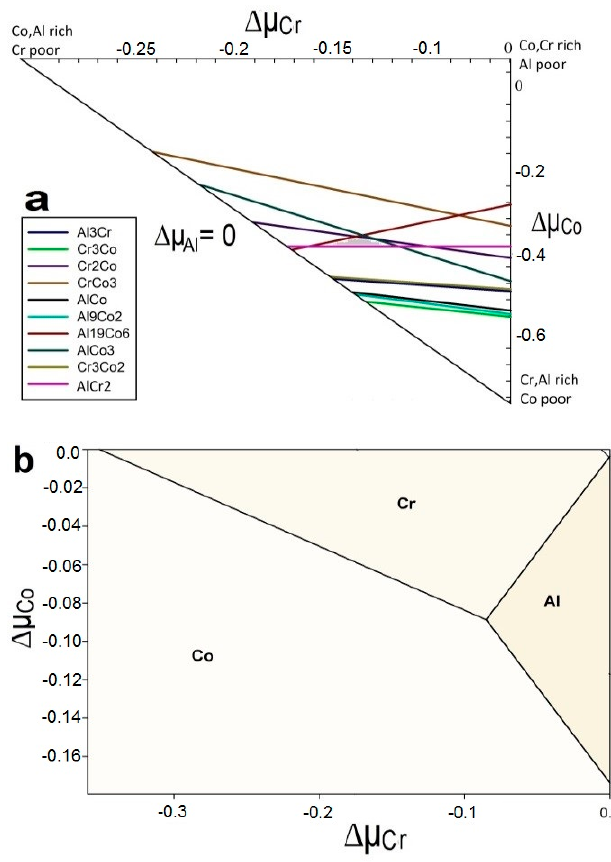
Figure 4. The stability phase diagrams of Co 2 CrAl in the ( a ) bulk, and ( b ) Heuslerene phases. Chemical potential changes are expressed in Rydberg unit.